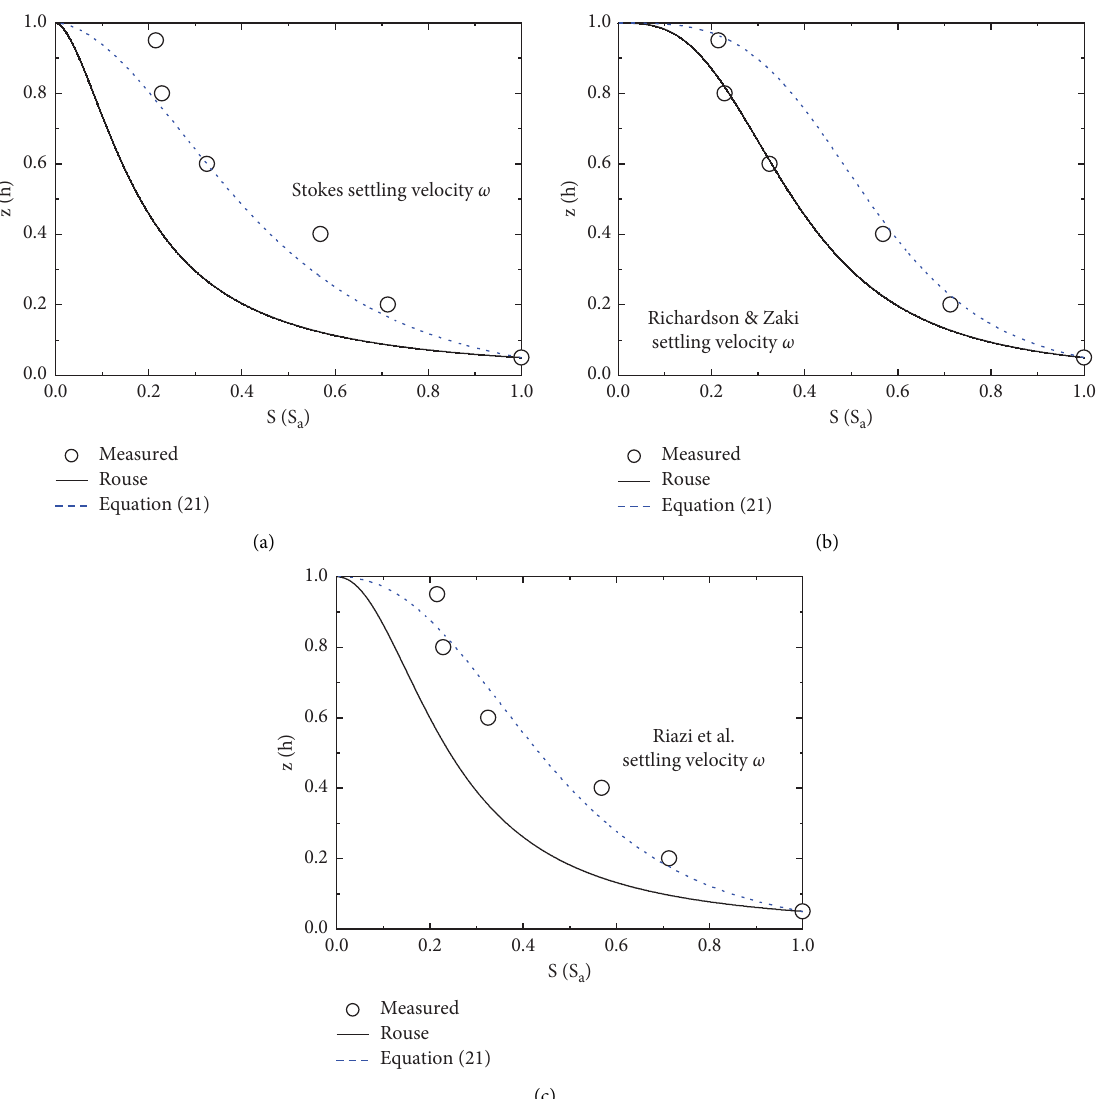
Figure 9: Suspended sediment concentration